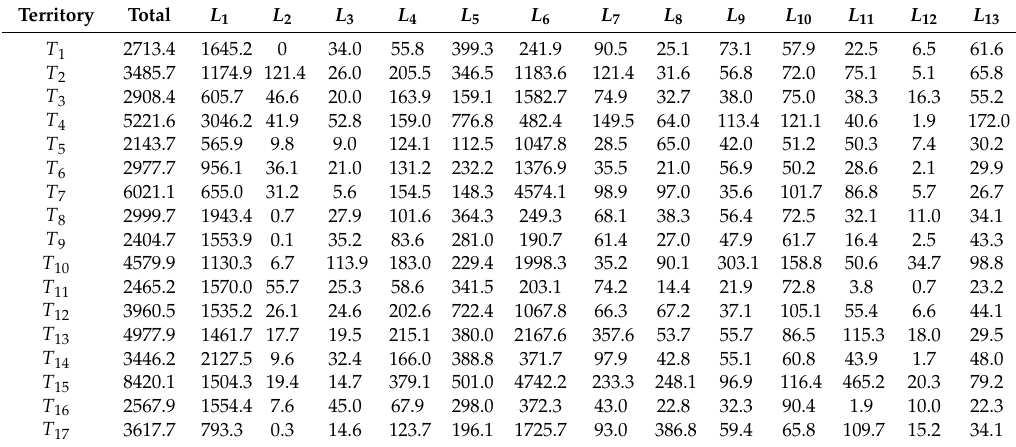
Table A1. Land acreage data of the Central Federal District in thousand hectares. Mean values for 2010–2018.